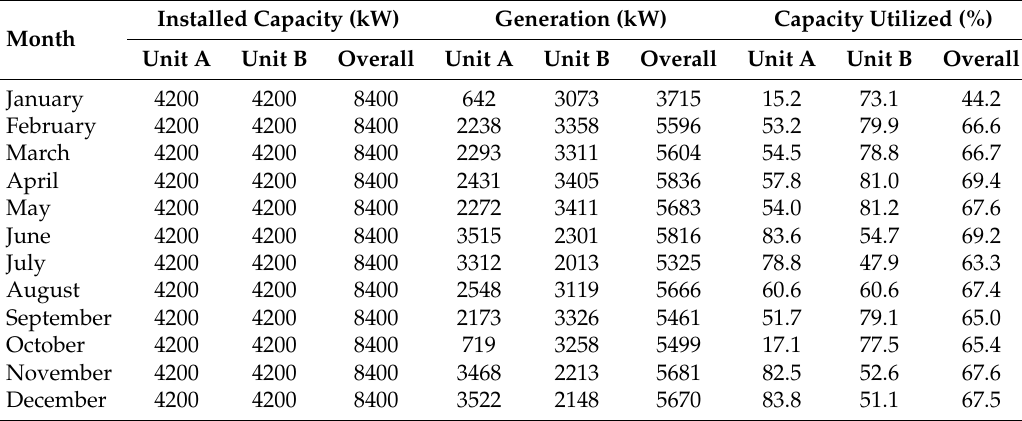
Table 2. Summary of UTP microgrid (installed capacity, monthly generation, and capacity